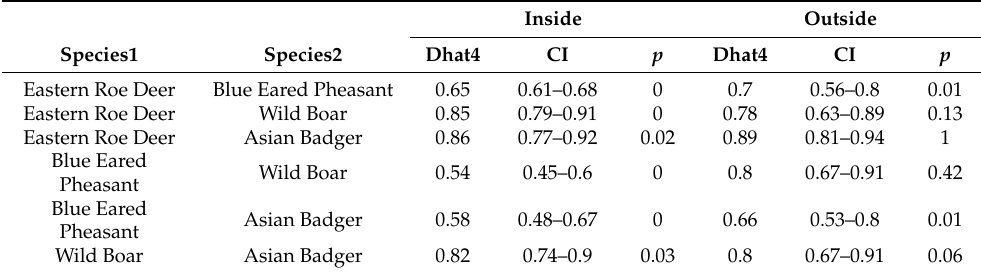
Table 5. Coefficients of daily activity overlapping (Dhat4), confidence intervals (CI) and p -level ( p ) for species inside and outside the reserve on the eastern Qinghai-Tibet Plateau in